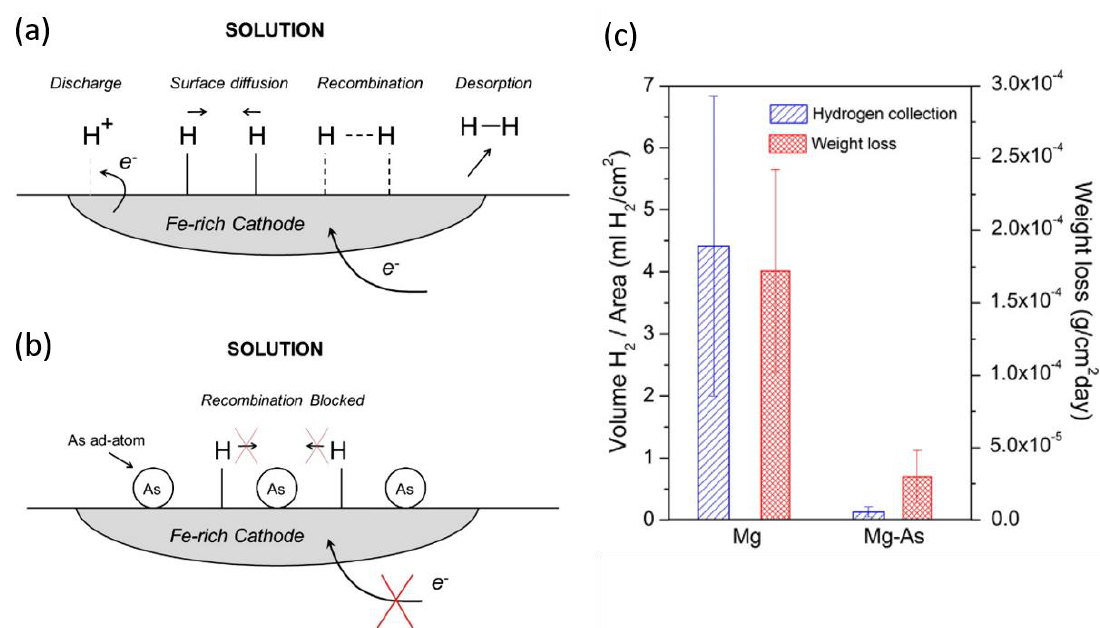
Figure 3. ( a , b ) Schematic representation of the mechanism of hydrogen recombination poisoning and ( c ) decreased corrosion rate in presence of arsenic alloyed with Mg [32]. Adapted from [32] with permission from Elsevier.